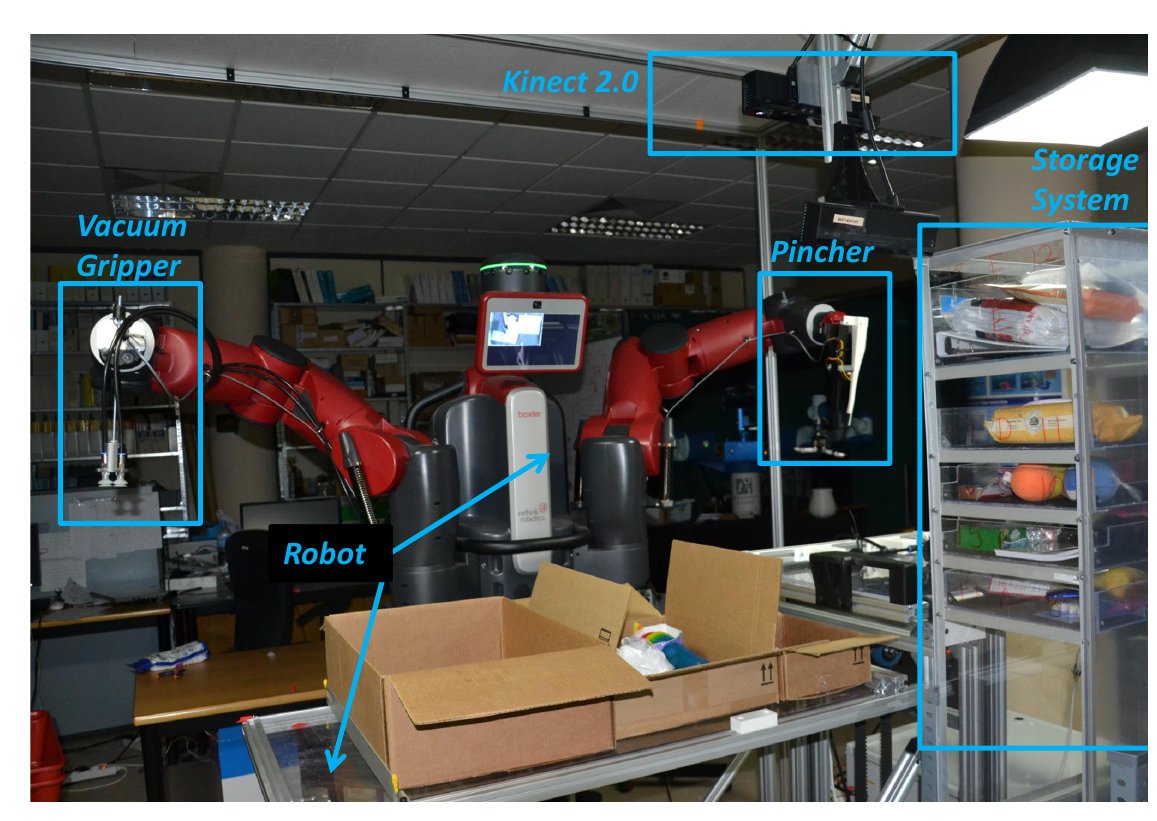
Figure 3. UJI RobinLab robot platform setup.